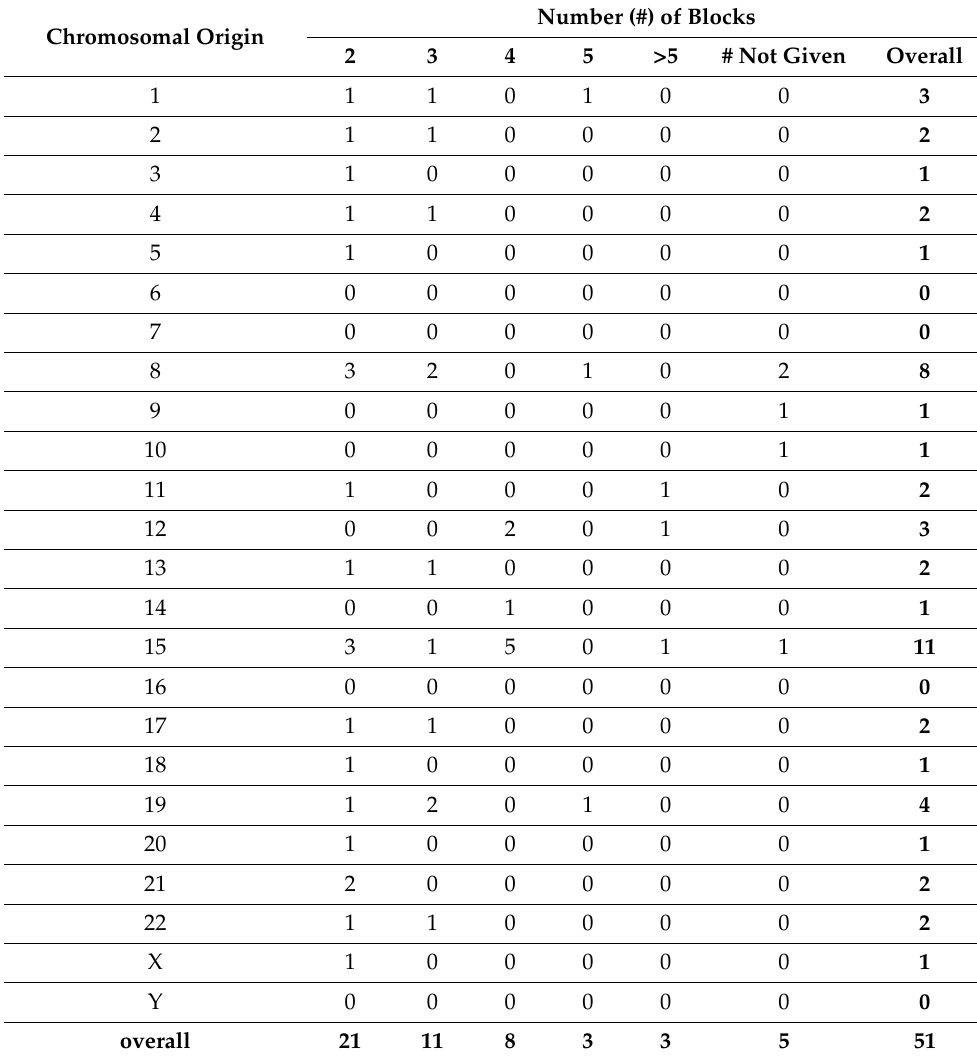
Table 2. Discontinuous sSMCs by chromosomal origin and indicating the number of identified euchromatic